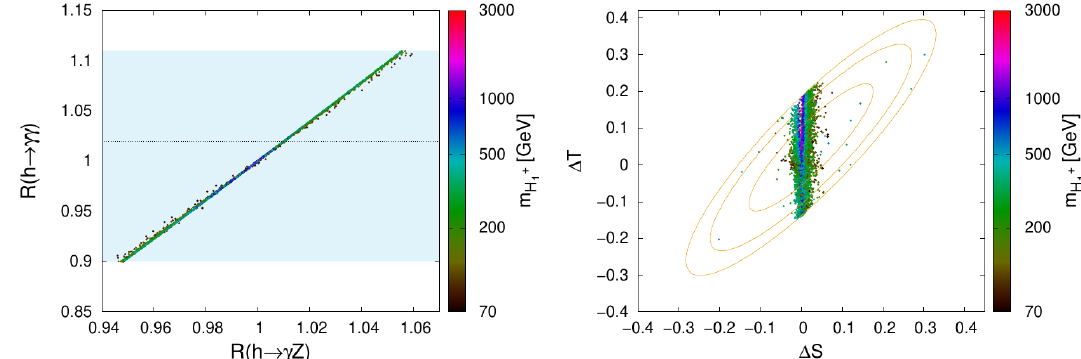
Figure 3 . Left: the Higgs decay modifiers of h → γγ, γ Z , where the colored band represents the allowed experimental values. Right: the oblique parameters ∆ T vs ∆ S , where the palette shows the light charged scalar